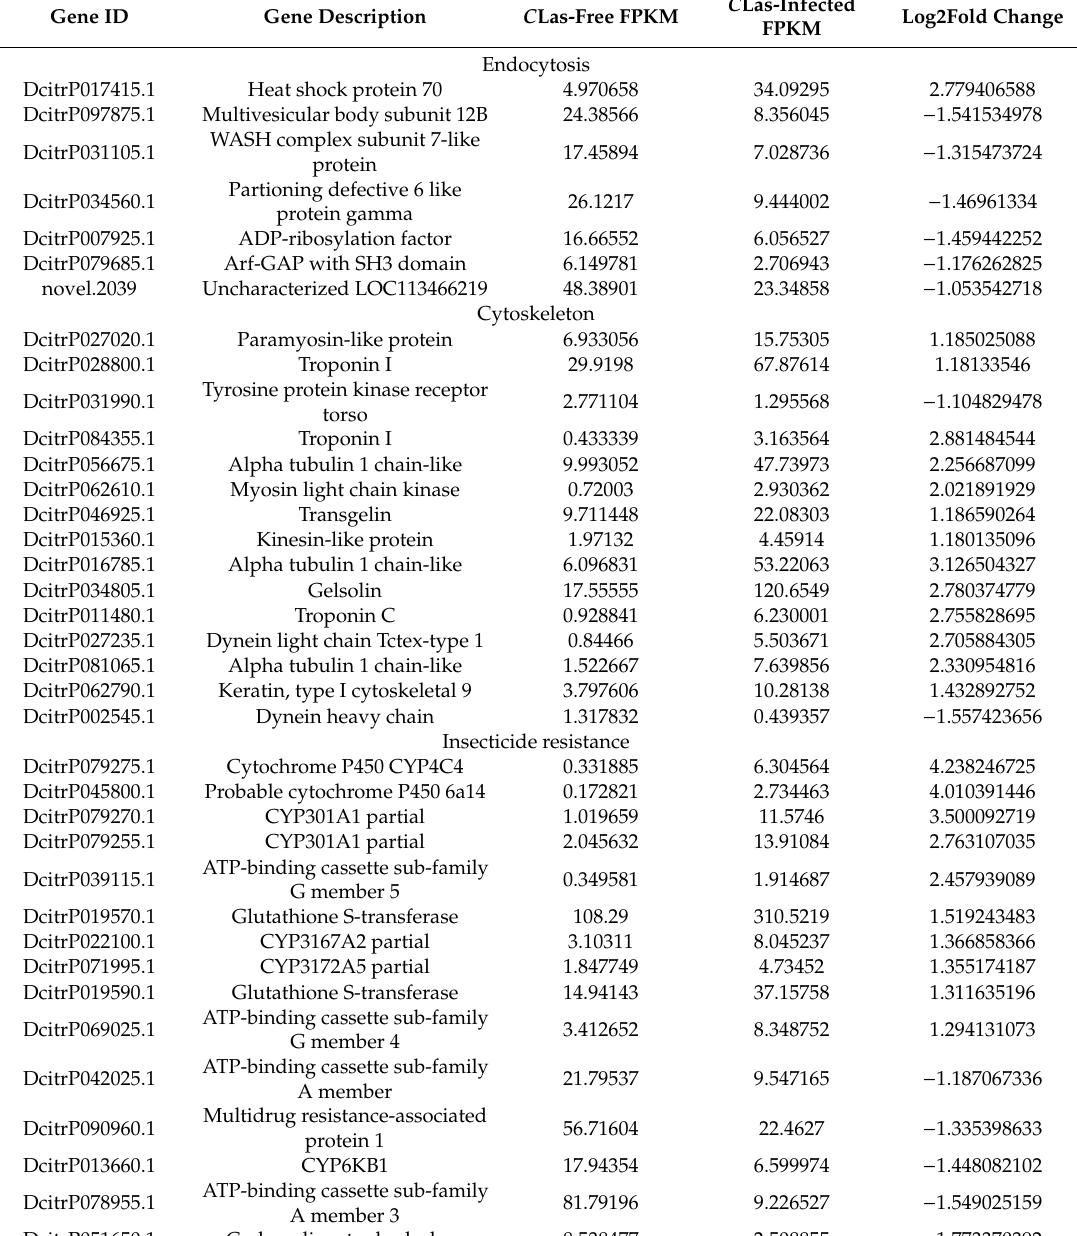
Table 3. Di ff erentially expressed genes upon CLas infection involved in endocytosis, the cytoskeleton and insecticide resistance, comparing C Las-infected groups and C Las-free